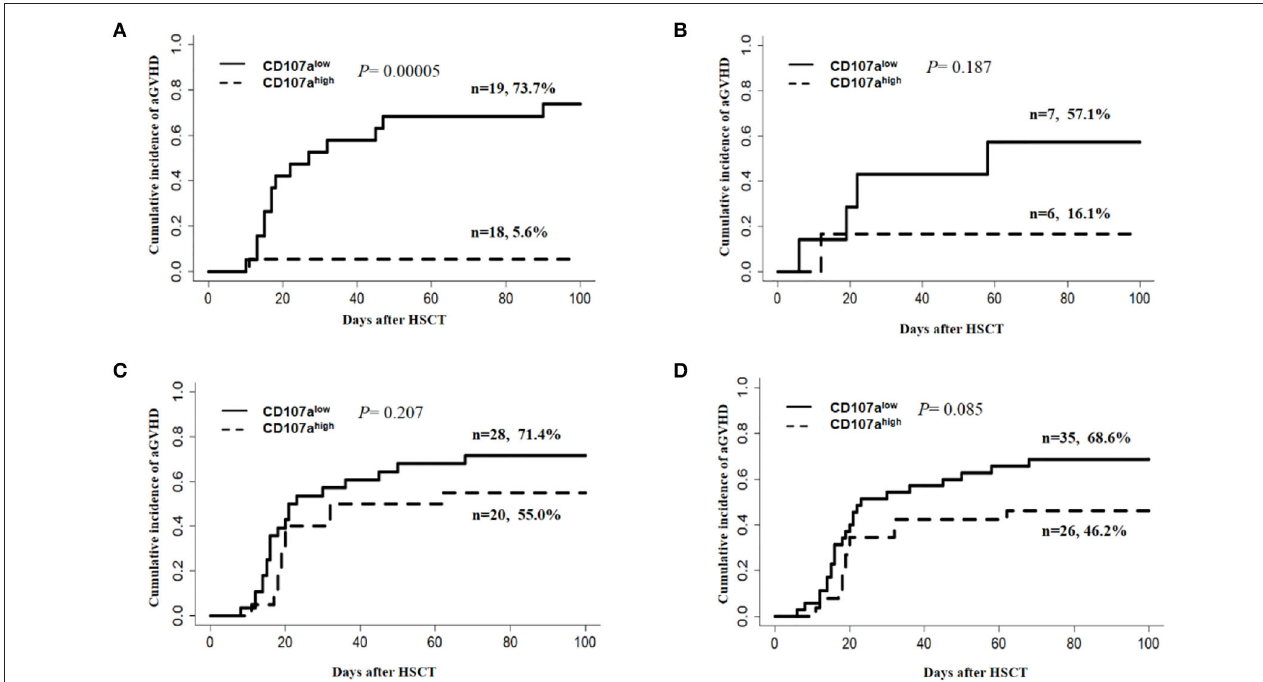
FIGURE 4 | Subgroup analysis for predictive value of the donor NK CD107a degranulation toward activated T cells for grade I–IV aGVHD. (A) HLA-matched related HSCT(MRD), (B) HLA-matched unrelated HSCT(MUD), (C) HLA-haplo-identical related HSCT. (D) Patients with ATG for the prophylaxis of